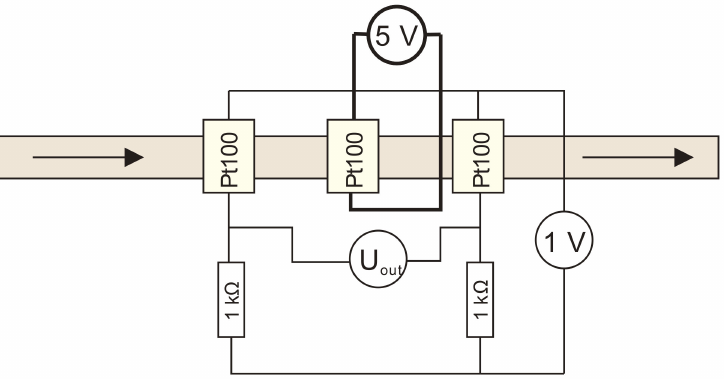
Figure 12. A wiring diagram of a constant voltage thermal mass flowmeter in S-H-S